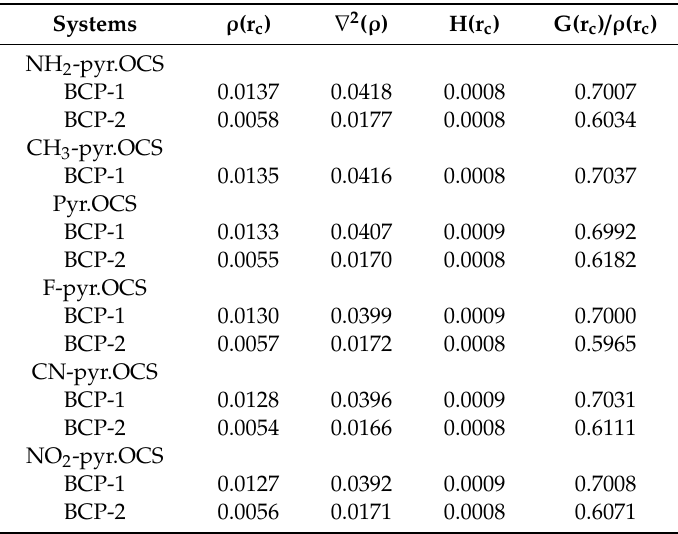
Table 6. Electron density values ρ (r c ), Laplacian of electron density ∇ 2 ( ρ ), total local energy H(r c ) and G(r c ) / ρ (r c ) values for the B complexes. All data are in a.u.